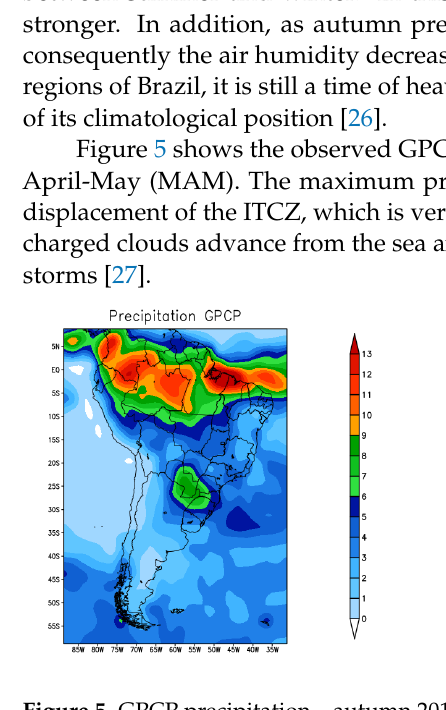
forecast models: BAM (Figure 6a); XGB (Figure 6b); and TF (Figure